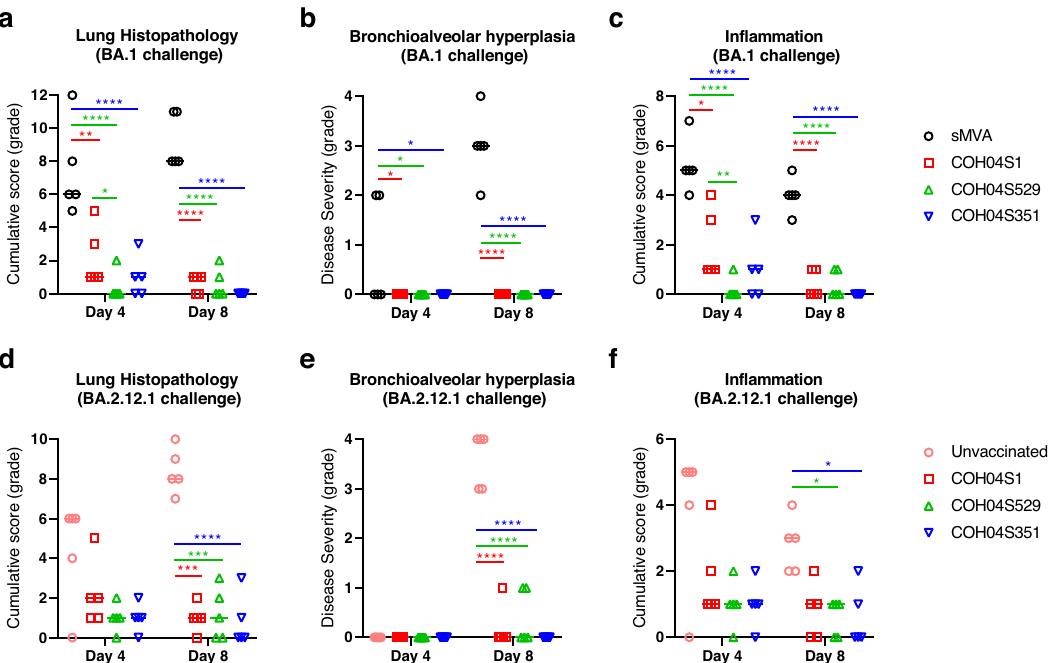
Fig. 5 COH04S1 and Omicron BA.1- and Beta-modi fi ed vaccines protect hamsters from lung pathology following challenge with Omicron BA.1 or BA.2.12.1. Hematoxylin/eosin-stained lung sections of COH04S1-, COH04S529, and COH04S351-vaccinated hamsters and control animals at days 4 and 8 following challenge with SARS-CoV-2 BA.1 ( a – c ) or BA.2.12.1 ( d – f ) variants were evaluated by a board-certi fi ed pathologist and microscopic fi ndings were graded based on severity on a scale from 1 to 5 (Supplementary Table 3). Cumulative pathology score of all histopathologic fi ndings ( a , d ), grading of bronchioalveolar hyperplasia disease severity ( b , e ), and severity of lung in fl ammatory microscopic fi ndings ( c , f ) are shown. Lines indicate median values. Two-way ANOVA followed by Tukey ’ s multiple comparison test was used following log transformation. * = 0.05 < p < 0.01, ** = 0.01 < p < 0.001, *** = 0.001 < p < 0.0001, **** = p < 0.0001. When not indicated, differences are not signi fi cant ( p >